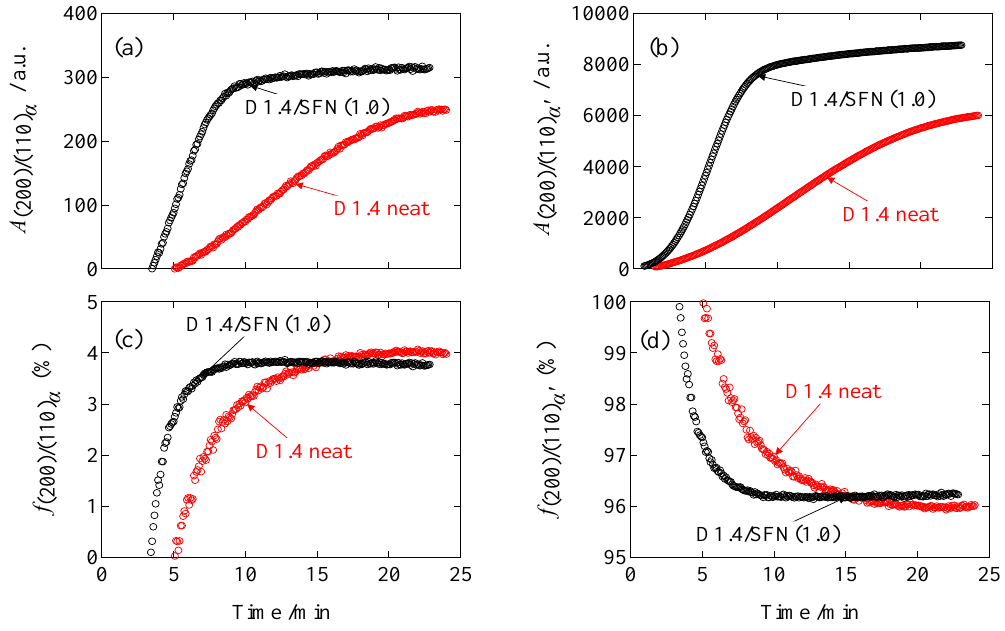
Figure 5. Plots of the peak area as a function of time for ( a ) the decomposed (200) / (110) α peak and for ( b ) the decomposed (200) / (110) α ’ peak, and fraction of ( c ) α phase and ( d ) α ’ phase.